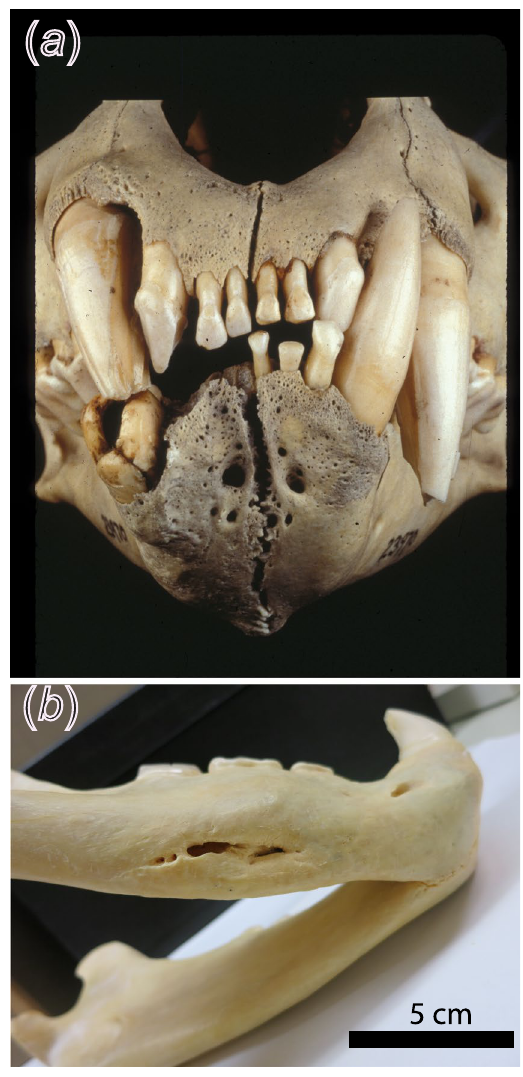
Figure 1. Images of injuries to Tsavo’s 1st man-eater ( a ), FMNH 23970 and the Mfuwe man-eater ( b ), FMNH 163109. Image ( a ), Field Museum of Natural History image Z-94320_11c by John Weinstein documents a broken lower right canine (which had a periapical abscess) and loss of the lower three right incisors - presumably from the kick of a struggling prey - and subsequent over-eruption of the upper right incisors and rotation of the upper right canine both labially and mesially in the absence of the interlocking lower canine. In ( b ), multiple oval-shaped intraosseous lesions are visible on the right mandible, superficial to an occluded mandibular canal and associated with a chronically draining fistula 15 . Again, these injuries are consistent with blunt trauma from a powerful ungulate